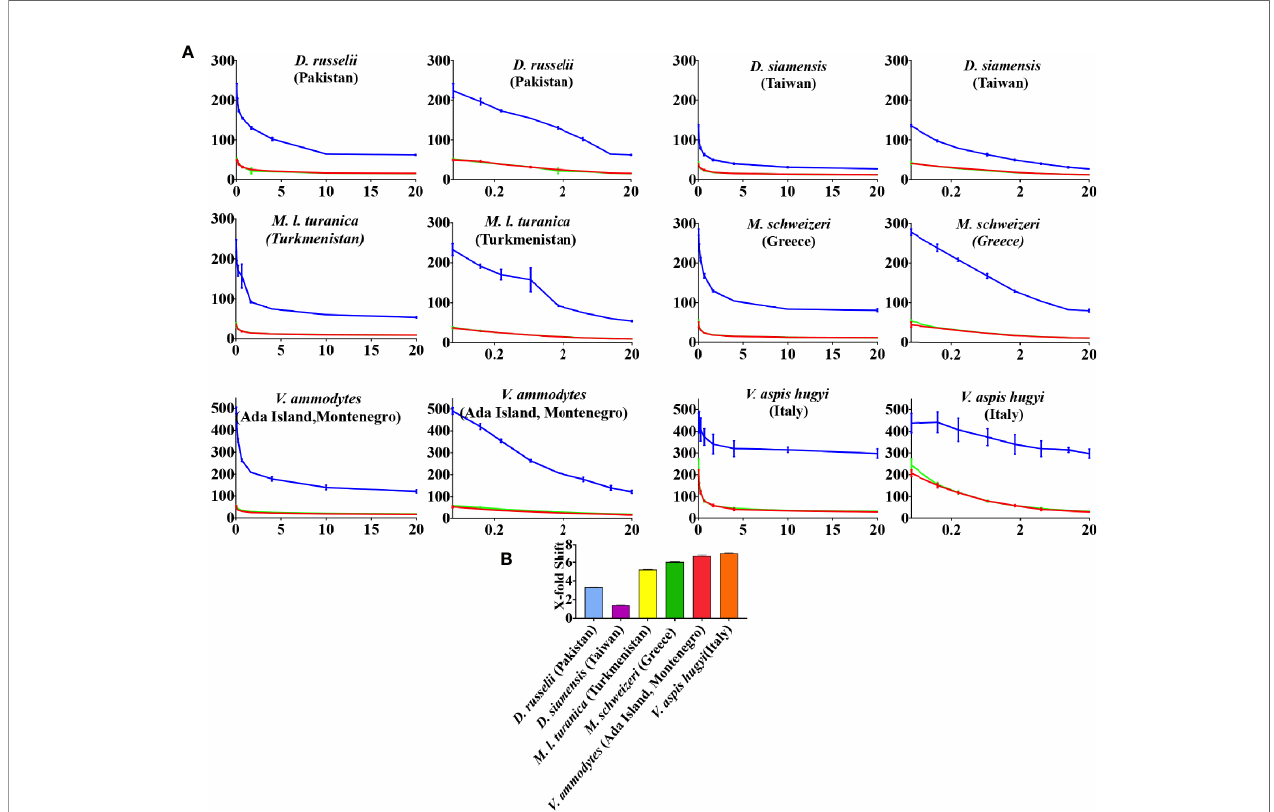
FIGURE 6 | (A) 8-point concentration curves, x-axis showing concentrations of venom in m g/ml and y-axis showing clotting times in seconds of human plasma with venom and relative inhibitor ef fi cacy. For each species, linear graphs are presented on the left and logarithmic views on the right. Shown are venom-induced clotting times (red curves), effect of venoms after preincubation with prinomastat ( fi nal concentration 0.2 mM%; spontaneous control- 484.8 +/- 11.0) (blue curves), and effect of venoms after preincubation with DMPS ( fi nal concentration 0.2 mM %; spontaneous control- 425.8 +/3.3) (green curves). Values are mean ± SD of N = 3 and shown as dots with error bars. Some error bars are too small to see and the failure of DMPS to shift the curves results in an identical line to the red (venom only) curves. (B) Bar graphs of X-fold magnitude of shift of plasma clotting time due to induction of prinomastat. X-fold magnitude of shift was calculated by the formula [(AUC of inhibitor + venom/AUC of venom) -1]. A value of 0 is no shift (no neutralization by inhibitor), while a value above 0 indicates neutralization by inhibitor. Values are mean ± SD of N =